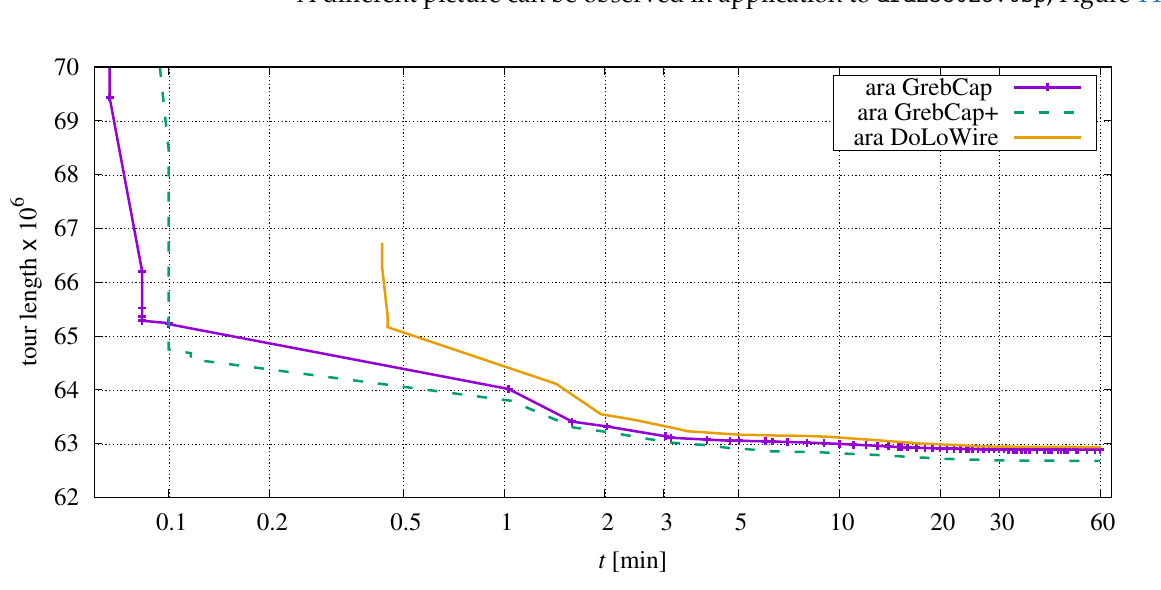
Figure 14. Comparison of tour length depending on elapsed time when using different initial-tour generators in application to